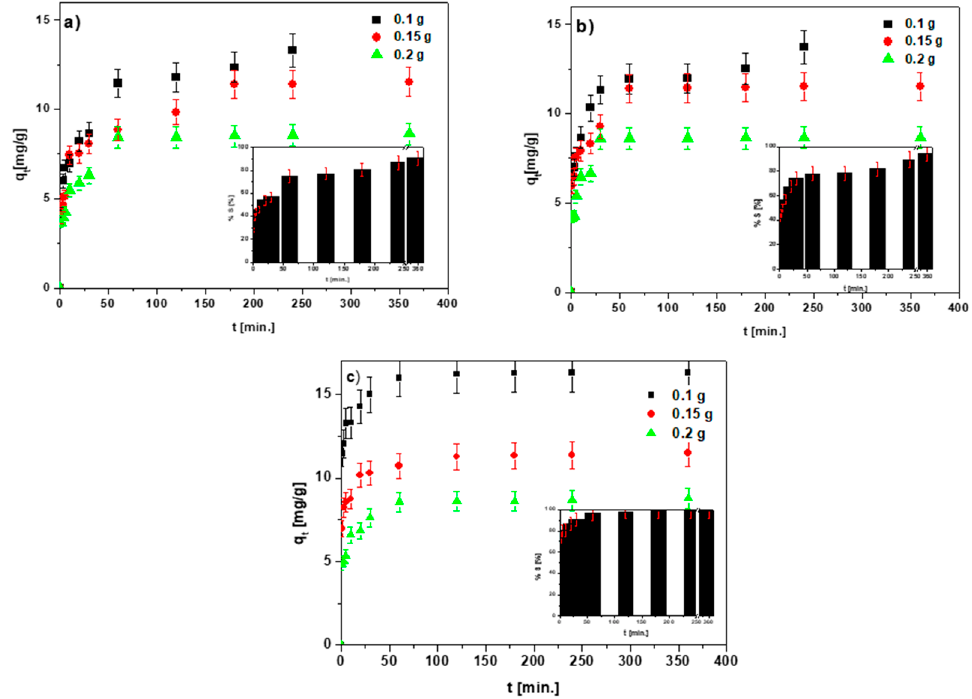
Figure 9. Effect of the sorbent mass on the Cu(II) ion sorption process depending on the phase contact time: ( a ) BC-CS 1-1, ( b ) BC-CS 2-1 and ( c ) BC-CS 4-1 (C 0 100 mg/L, pH 5, shaking speed 180 rpm, temperature 293 K).